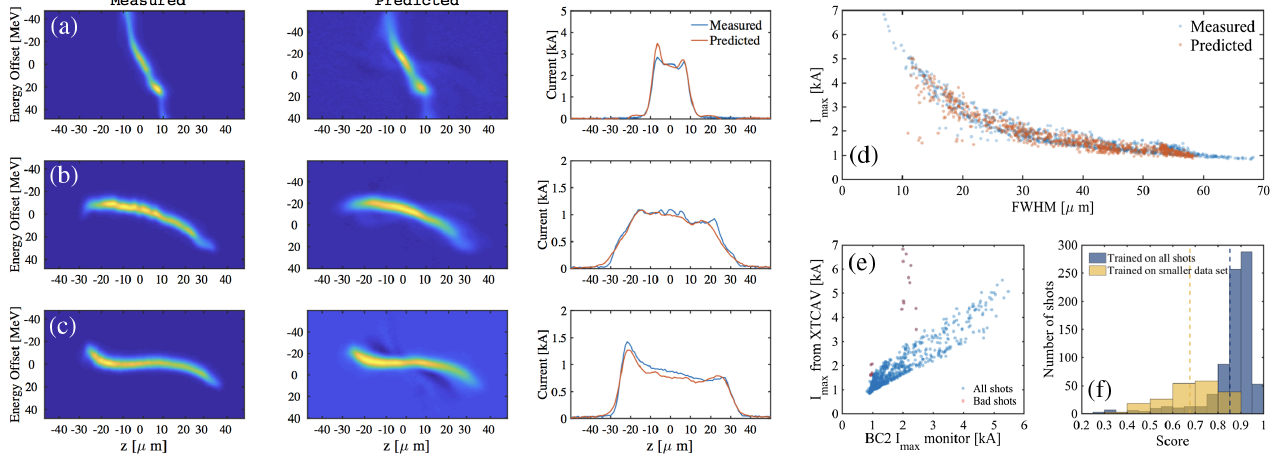
FIG. 4. (a) – (c) Examples of reconstructed LPS and current profiles from the LCLS accelerator. The measured data is collected using the XTCAV and the prediction is made using two separate NNs for the LPS and the current profile. The plots show good agreement in predicting both the LPS and the current profile. For some shots the LPS reconstruction suffers from numerical artifacts [see (c)] which lead to an imperfect reconstruction. (d) Measured and predicted values for the peak and FWHM of the current profile. (e) Correlation between peak current from the XTCAV and the BC2 current monitor highlighting a number of bad shots (2% of the total) where the difference between the two values is large and the prediction accuracy is low. (f) Score for the 2D LPS prediction model trained on 3236 shots and tested on 808 shots randomly selected from the entire data set (grey). Score for the 2D LPS prediction with model trained on 410 shots from the start of the data set and tested on 200 shots recorded at the end of the data set two hours later